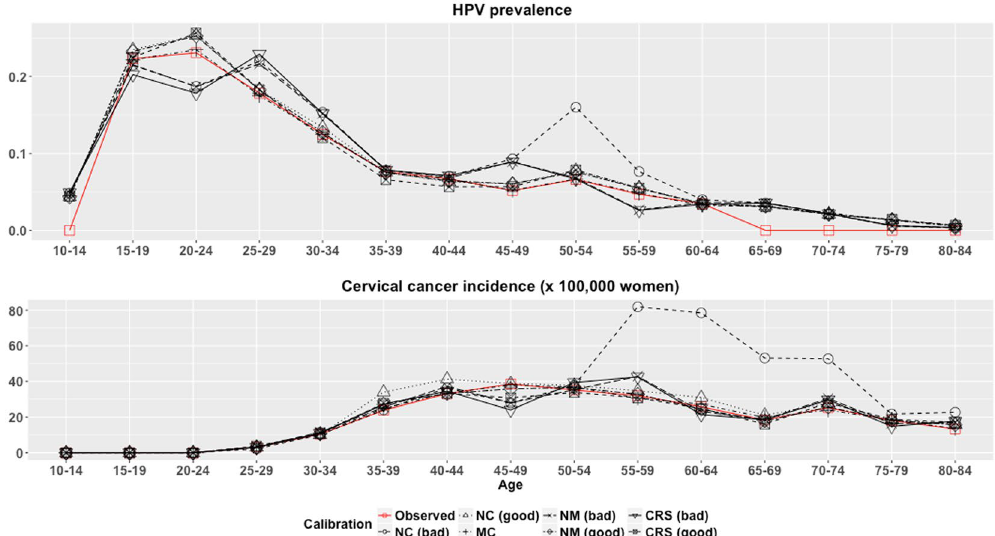
Figure 1. Model predicted values for age-specific HPV prevalence and cervical cancer incidence by calibration approach and input matrix. NC = No calibration, MC = Manual calibration, NM = Nelder-Mead, CRS = Controlled random